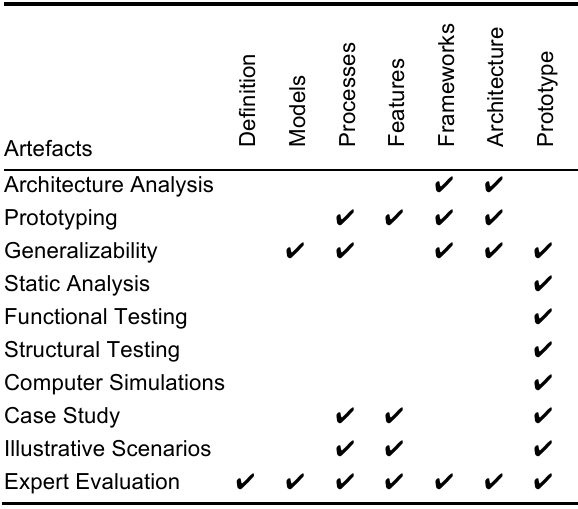
Table 3 . Research artefacts and evaluation